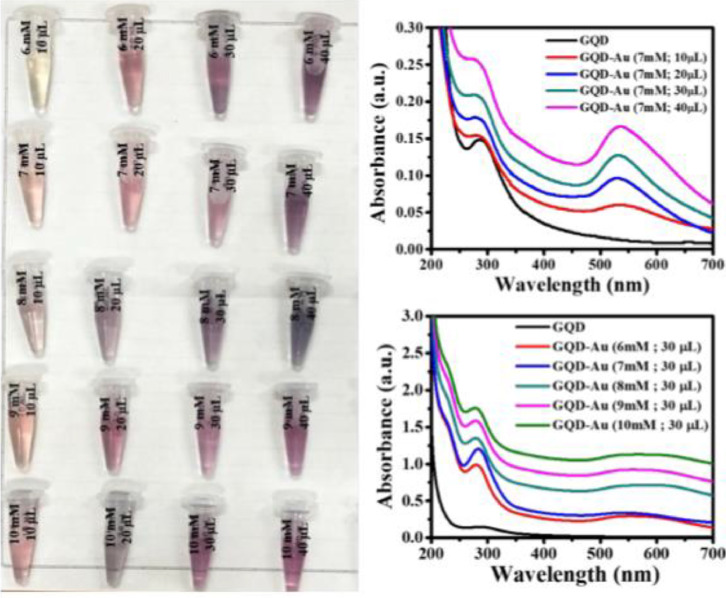
UV–Vis absorbance spectra of GQD-Au hybrid nanoparticles obtained with different (A) volumes (7 mM HAuCl4•3H2O solution) and (B) concentrations (30 µL of HAuCl4•3H2O).